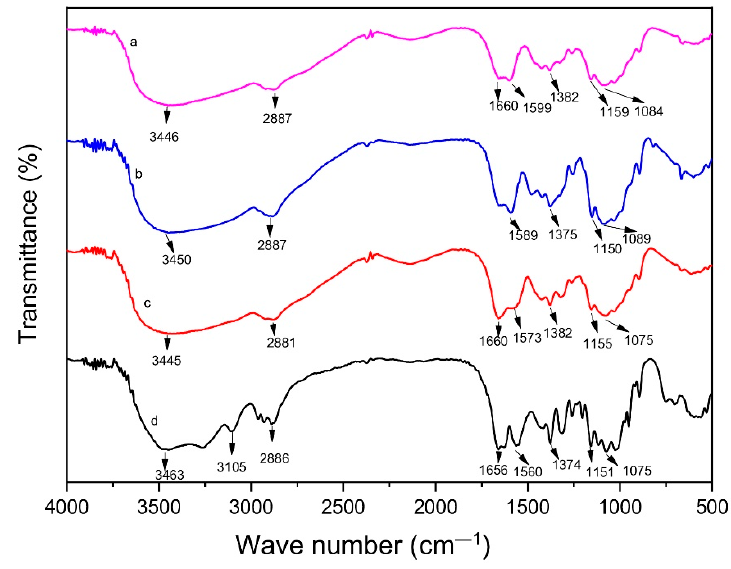
Figure 4. FTIR spectrum of low molecular weight chitosan ( a ), native chitosan ( b ), commercial chitosan ( c ), and ( d ) chitin.